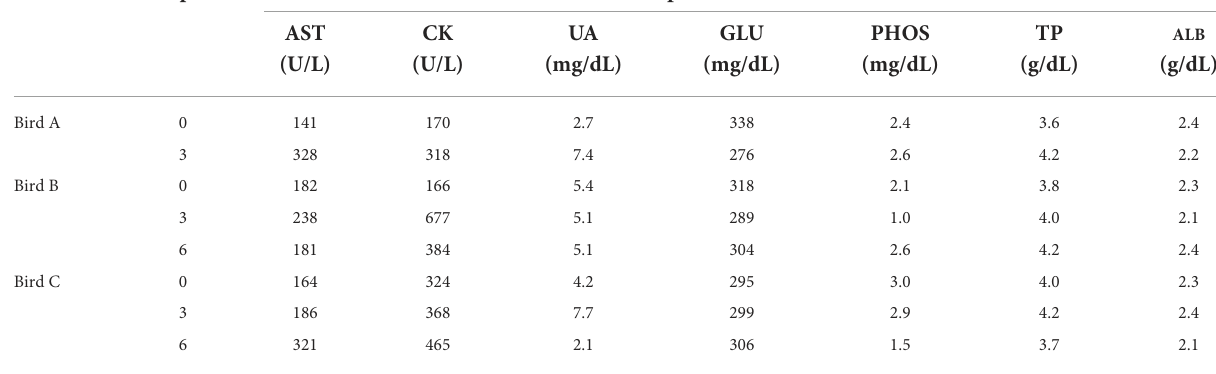
TABLE 1 Changes in chemical parameters in blood of the inoculated white-tailed sea eagles.